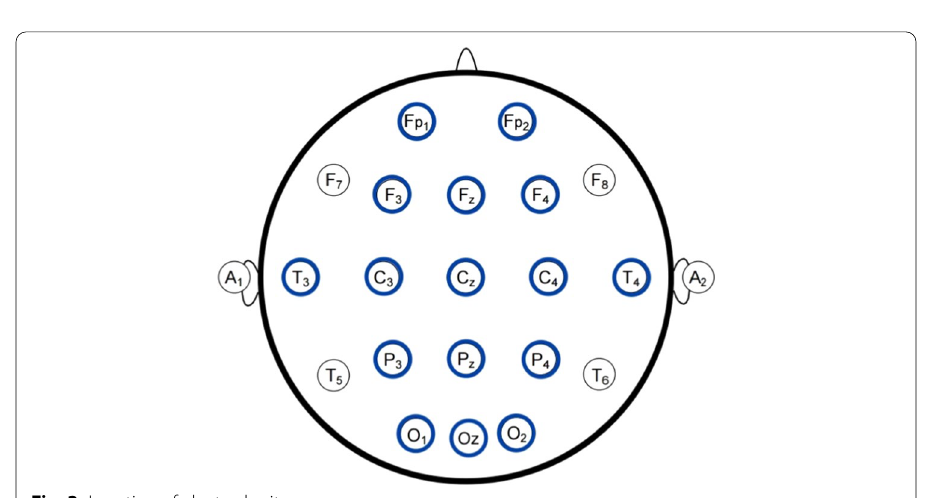
Fig. 3 Location of electrode